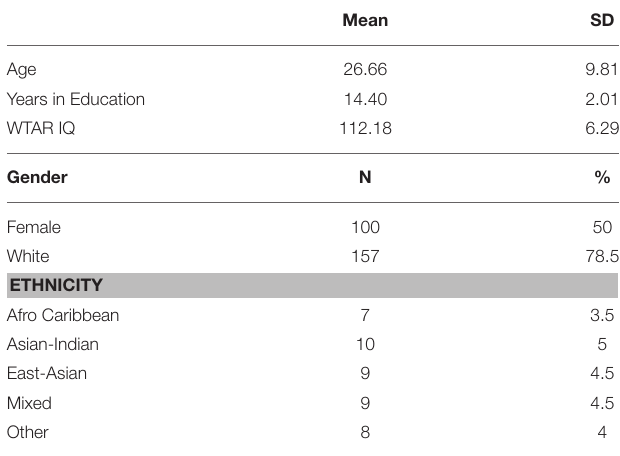
TABLE 1 | Demographic characteristics of sample ( N = 200 ), stratified by age, IQ, gender, and ethnicity for the standardization of the EMOTICOM neuropsychological test